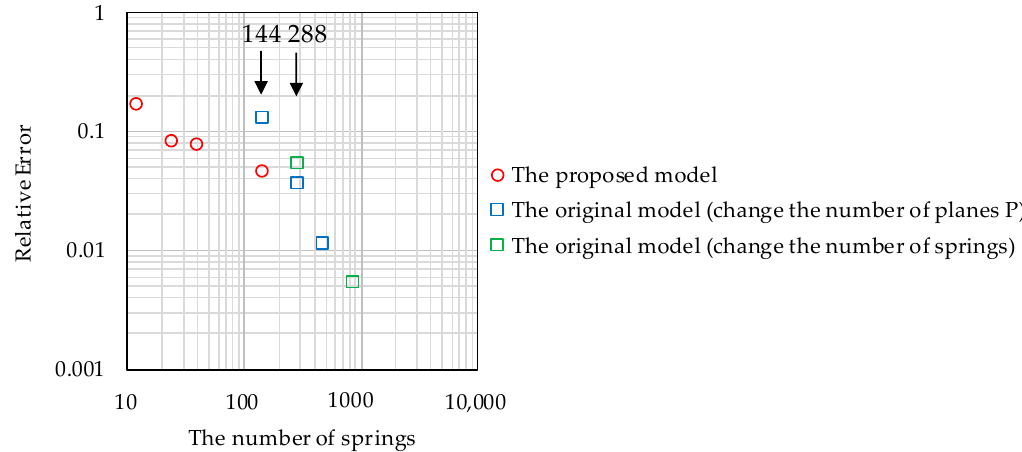
Figure 6. The relative error due to difference in the number of springs against cyclic simple shear loading by finite element total stress analysis method with a single solid element; when the load τ zx of 30 kPa was used.